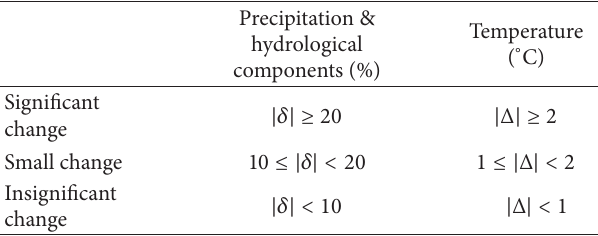
Table 1: Classification of magnitude for climatic and hydrological changes. 𝛿 and Δ represent relative change and absolute change.